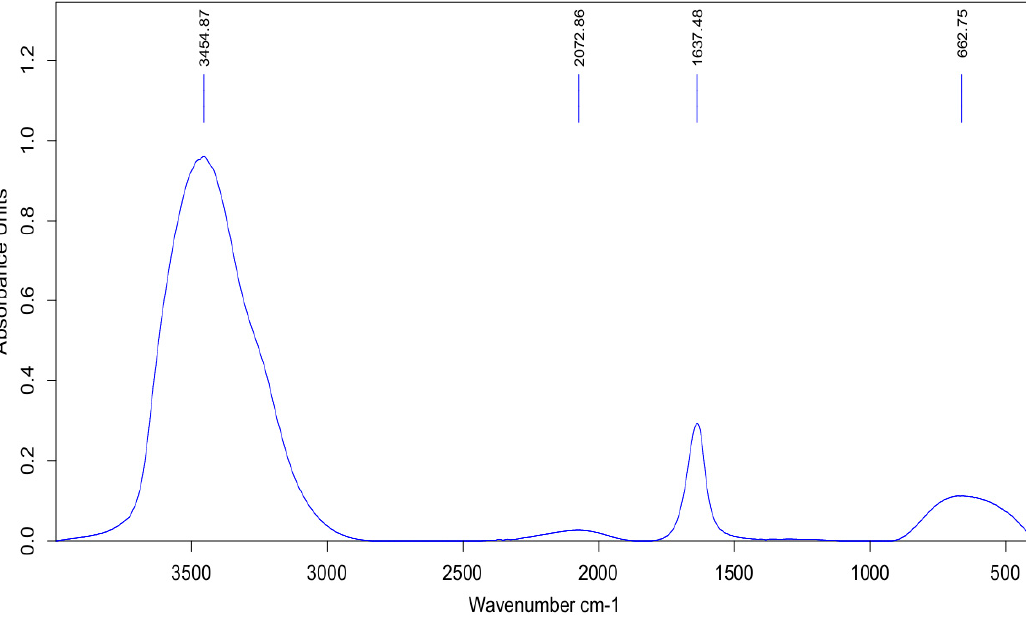
Figure 2. Fourier transform-infrared (FT-IR) spectrum of J. regia leaf extract.